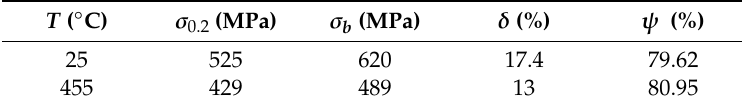
Table 2. Monotonic tensile properties of 2.25Cr1Mo